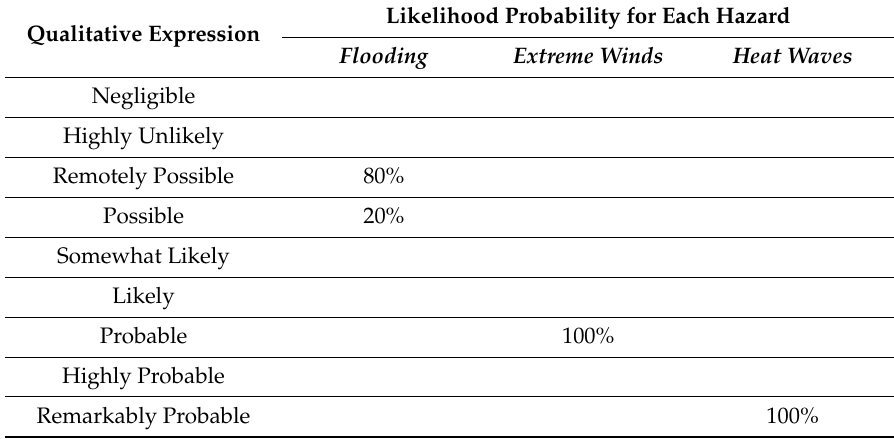
Table 9. Expected annual likelihood for anticipated hazards for CLIRMI mine with adaptation actions.